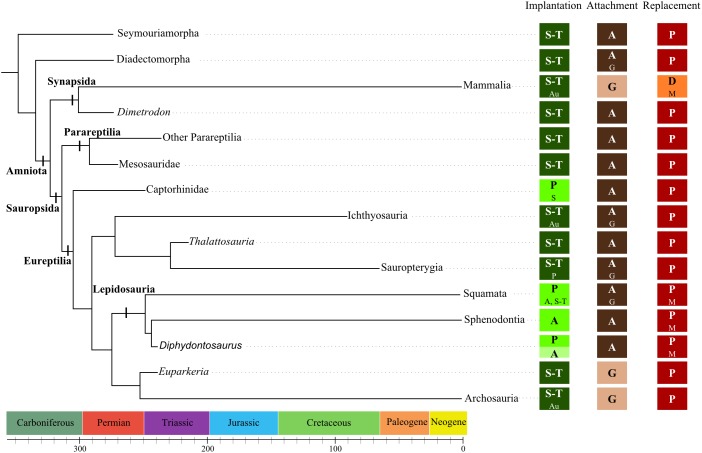
Dental features among early amniotes. Cladogram presenting some of the groups of stem or early Amniota. The dental features associated with each group are the assumed ancestral state for the groups or the described states for the genera (in bold). Other states that have been described in the groups are indicated with a smaller font. Implantation = geometry of implantation (S, subthecodonty; T, thecodonty; P, pleurodonty; A, acrodonty; Au, aulacodonty) Attachment = nature of the attachment (A, ankylosis; G, gomphosis) Replacement = number of replacement generation (P, polyphyodont; D, diphyodont; M, monophyodont). From (Romer and Price, 1940; Edmund, 1960, 1969; Ewer, 1965; Dong, 1972; Evans, 1984; Whiteside, 1986; Laurin and Reisz, 1995; Laurin, 1996b; Small, 1997; Rieppel, 2001; Cabreira and Cisneros, 2009; Dyke and Kaiser, 2011; Macdougall and Modesto, 2011; Pretto et al., 2012; LeBlanc and Reisz, 2013, 2015; Benton et al., 2015; Sassoon et al., 2015; de Miguel Chaves et al., 2018).